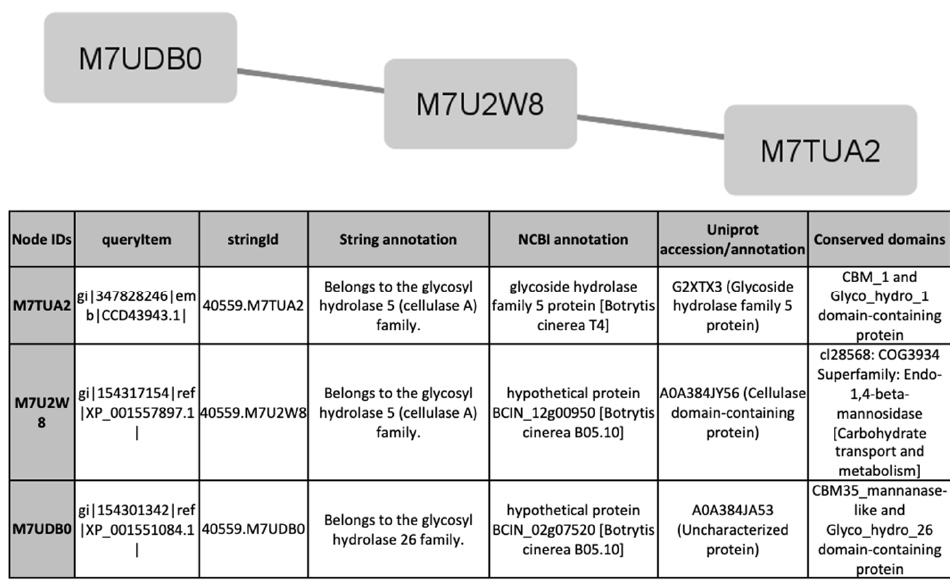
Figure 7. Cluster 14, found in the TCW condition using the STRING and MCODE, containing exclusive and overexpressed proteins of the secretome, membranome, phosphoproteome, phosphomembranome, and surfactome in the TCW condition, and composed of proteins related to metabolism of plant cell wall polysaccharides.